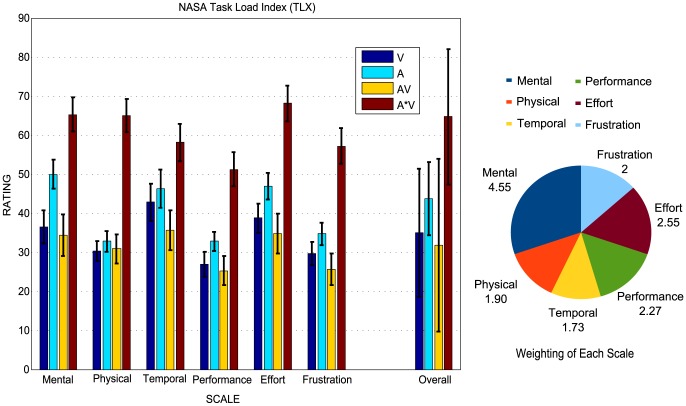
The NASA TLX workload and the overall weighted score of different conditions.The left column shows the mean rating with the standard deviation (SD) for each subscale and the overall weighted workload for each condition. The pie chart shows the grand-averaged weighting for each subscale. The total weighting is 15, due to 15 pair-wise comparisons of the sub-scales (see section 2.4).